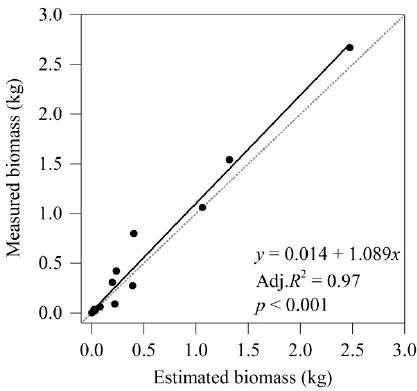
Figure 2. Scatterplot of the estimated ( x -axis) and the measured ( y -axis) values for the first-order root branch ( n = 18). The dashed line indicates 1:1 equivalence. Linear regression and associated Adj. R 2 are shown.